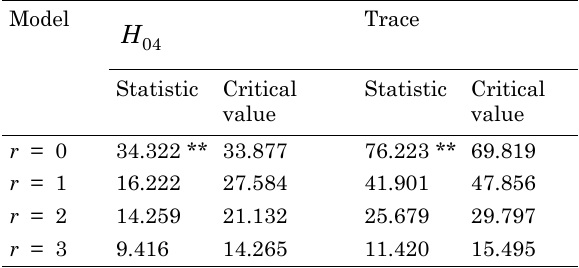
Table 7. Johansen’s multivariate cointegration tests